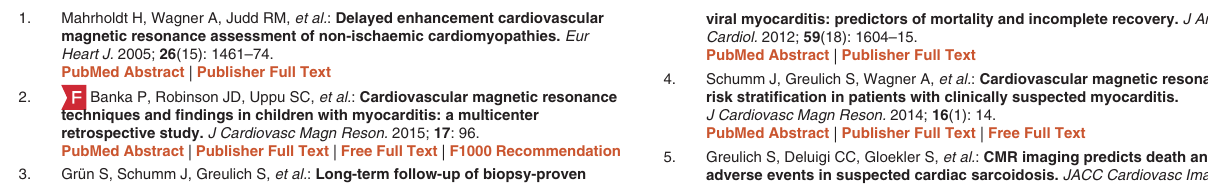
FFR, fractional flow reserve; ICD, implantable cardioverter defi- brillator; LGE, late gadolinium enhancement; LV, left ventricular; SCD, sudden cardiac death; T2w, T2-weighted; VT, ventricular tachycardia.